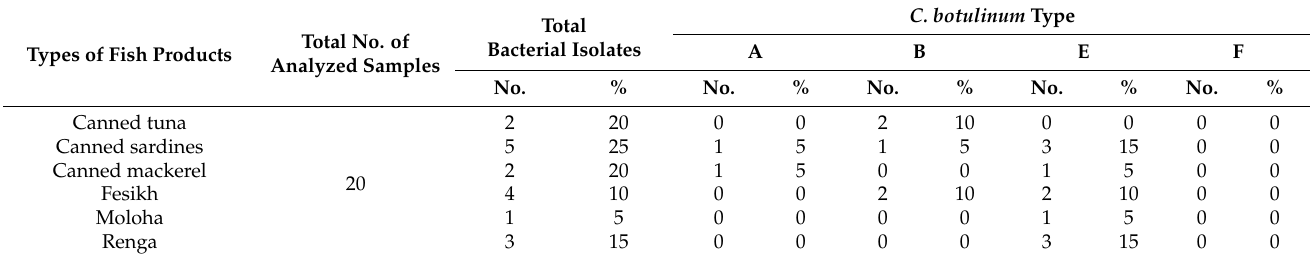
Table 3. Detection of C. botulinum types (A, B, E, and F) in fish product samples from the Gharbia